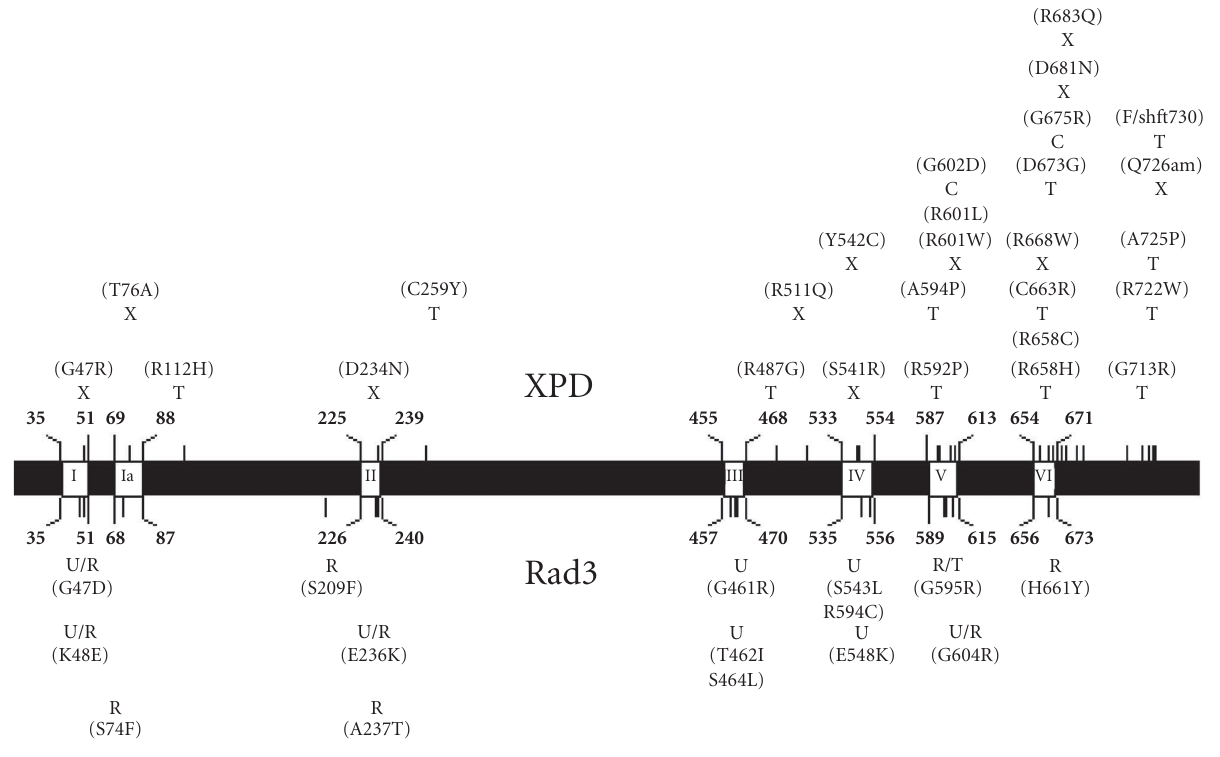
Figure 1. Amino acid changes in the human XPD and budding yeast Rad3 helicases that lead to phenotypic changes. The primary amino acid sequences of human XPD and yeast Rad3 are represented by the black bar. The seven conserved helicase domains are represented by white boxes and are named according to the accepted nomenclature [42]. The positions of these domains in the primary sequence are listed in bold print as described in [46]. Positions of altered residues in the primary sequence of XPD in XP, XP/CS, and TTD patients [44] are marked with a light hash mark above the black bar. The corresponding diseases are marked with an X for XP, a C for XP/CS, and a T for TTD. The amino acid changes are listed in parentheses. Changes in the Rad3 primary sequence [38, 39] are represented by hash marks below the black bar. The corresponding phenotypic changes are denoted by a U for UV sensitive, an R for elevated recombination, and/or mutation, and a T for transcription defective. Corresponding amino acid changes are listed in